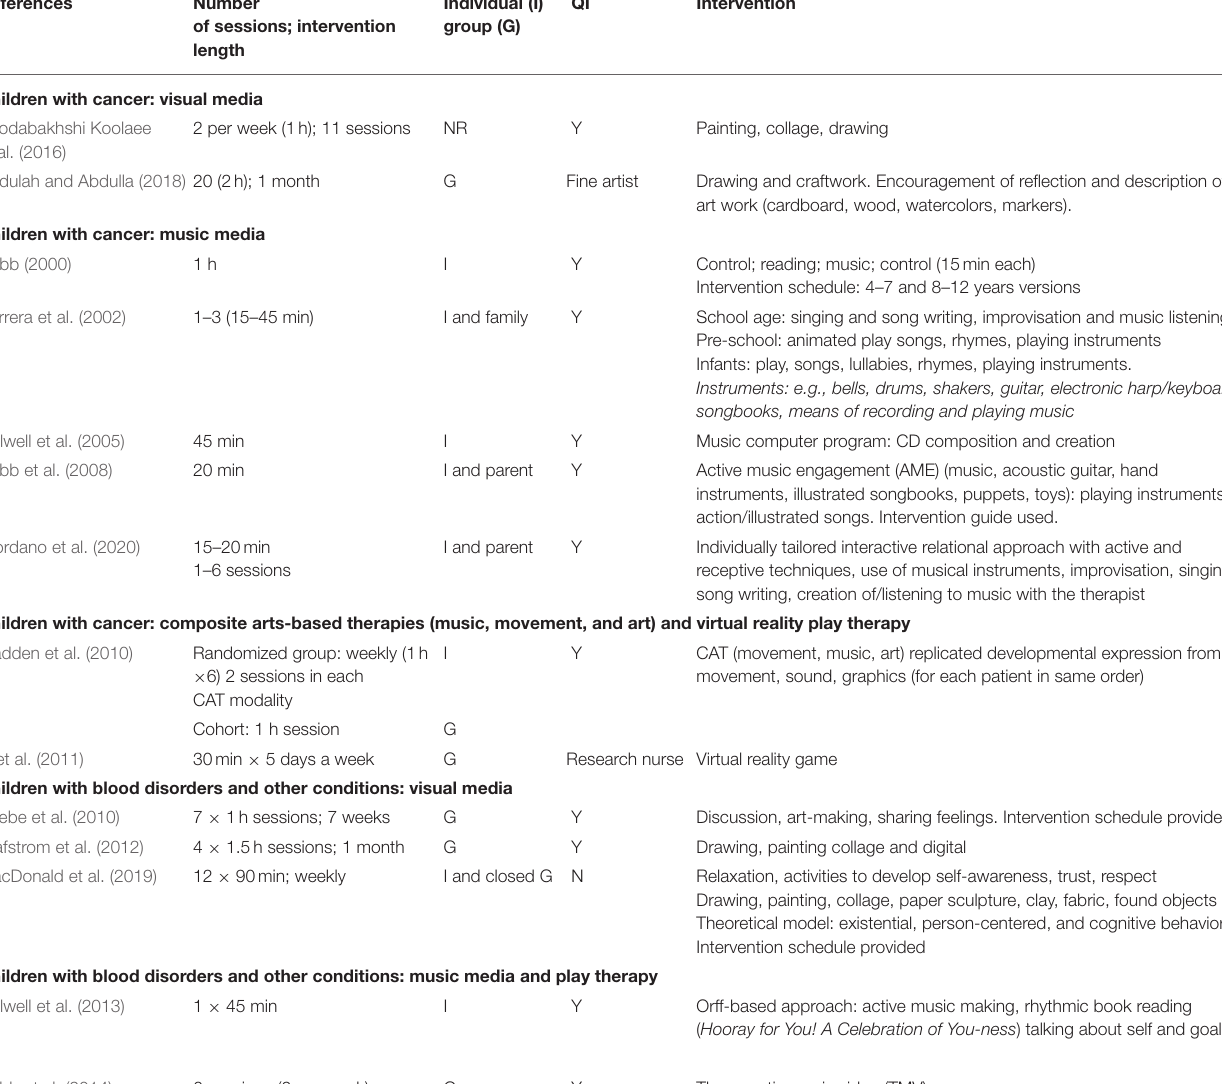
TABLE 3 | Intervention